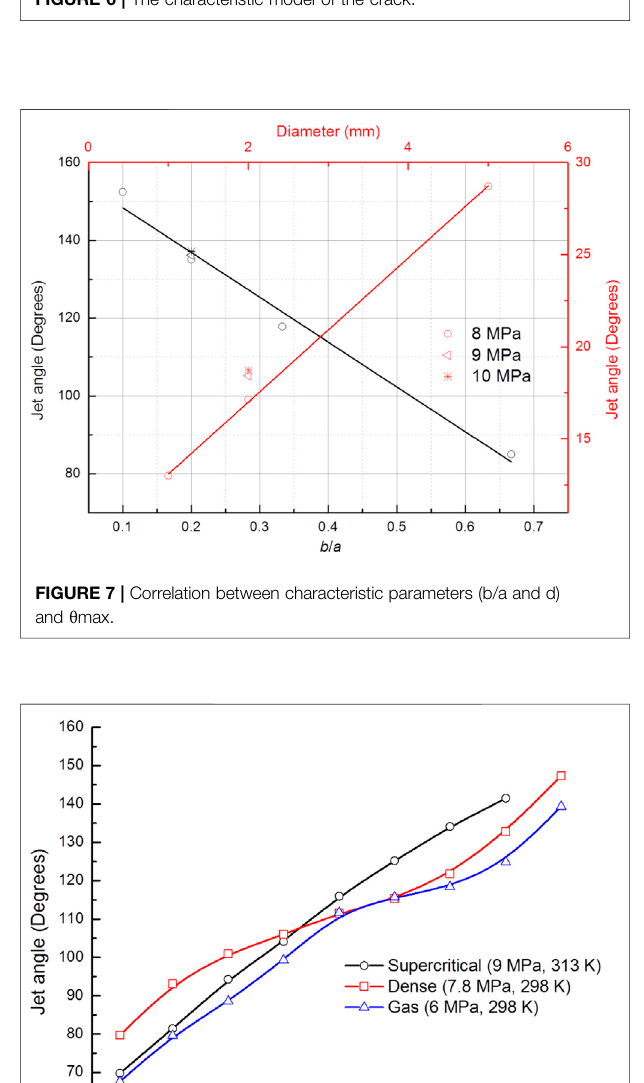
FIGURE 6 | The characteristic model of the crack.